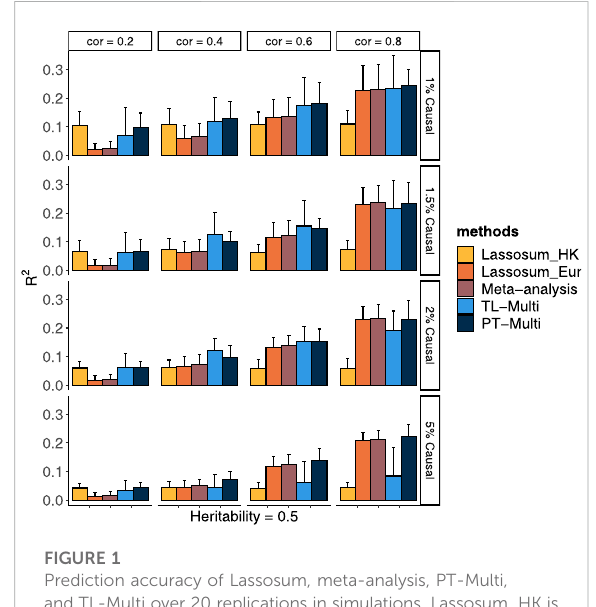
FIGURE 1 Prediction accuracy of Lassosum, meta-analysis, PT-Multi, and TL-Multi over 20 replications in simulations. Lassosum_HK is Lassosum for the Hong Kong population, and Lassosum_Eur is Lassosum for the European population. Heritability was fi xed at0.5anddifferentgeneticcorrelations (0.2, 0.4,0.6,and0.8)with different causal variant proportions (1%, 1.5%, 2%, and 5%) were generated. A total of 50,000 European samples and 1,000 Hong Kong samples were simulated. The variants were generated from thecommonvariants ofthe fi rstfour chromosomes(21,477SNPs). The prediction accuracy was measured by R 2 between the simulated and true phenotypes. The error bar indicated the upper bound of a 95% con fi dence interval over 20